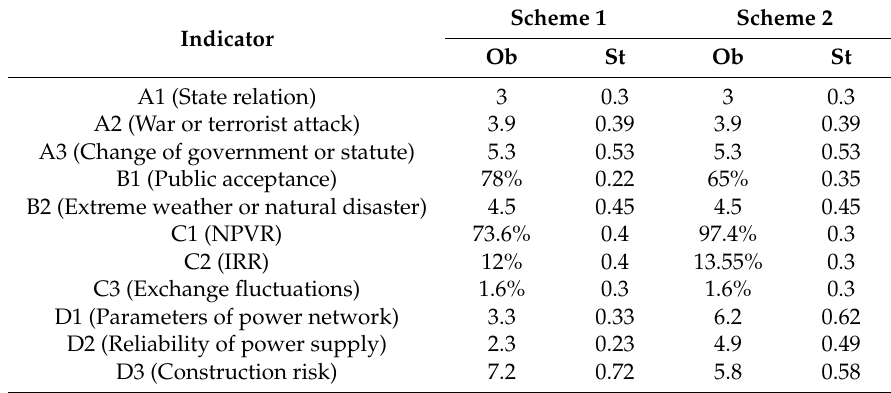
Table 9. The measurement and standardization of each